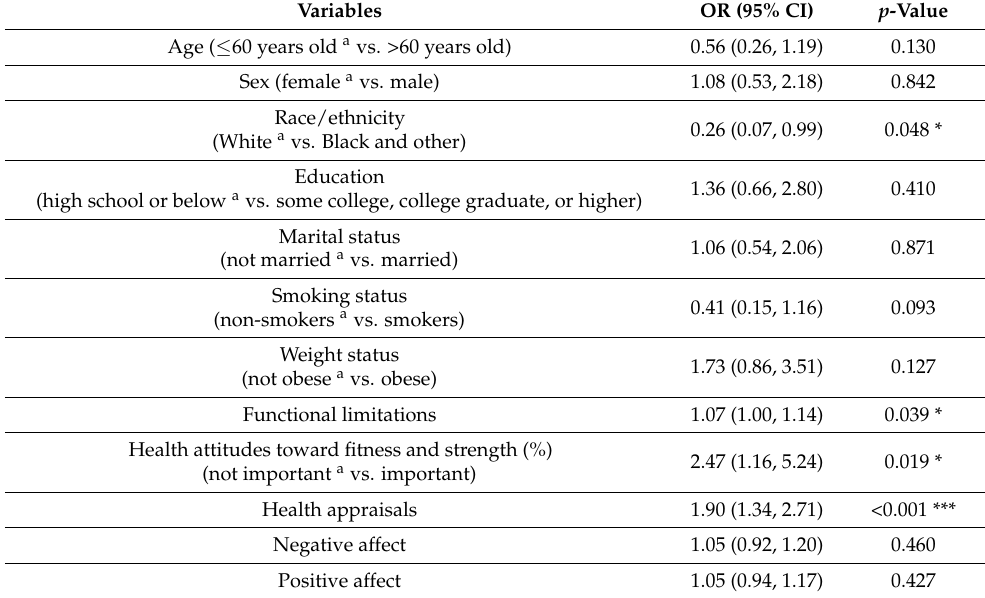
Table 2. Multiple logistic regression analysis examining variables associated with physical activity status among adults with COPD, controlling for socio-demographic factors and functional limitations (n =